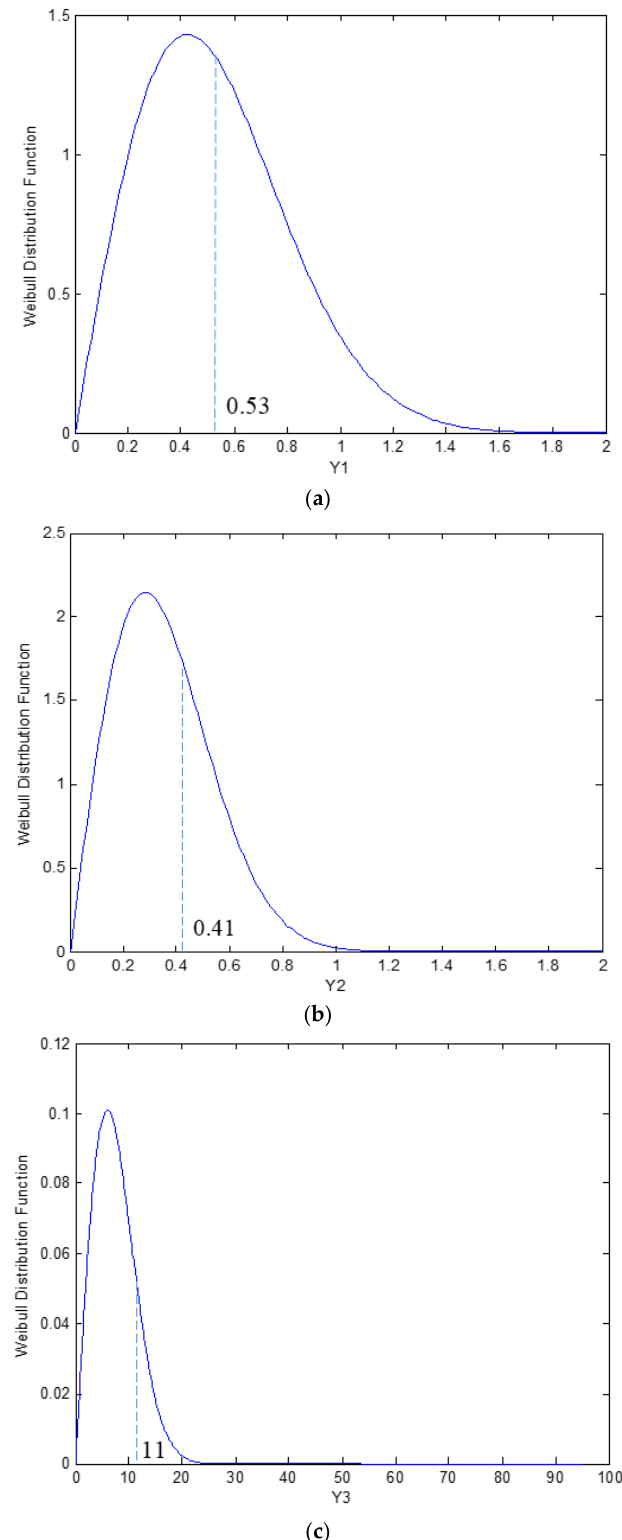
Figure 9. The probability distribution function of non-Fickian parameters for the normalized thick- ness: ( a ) Fickian to non-Fickian maximum moisture content ratio φ ; ( b ) normalized non-Fickian diffusivity per square thickness α ’ ; and ( c ) normalized non-Fickian initiation time t o ’